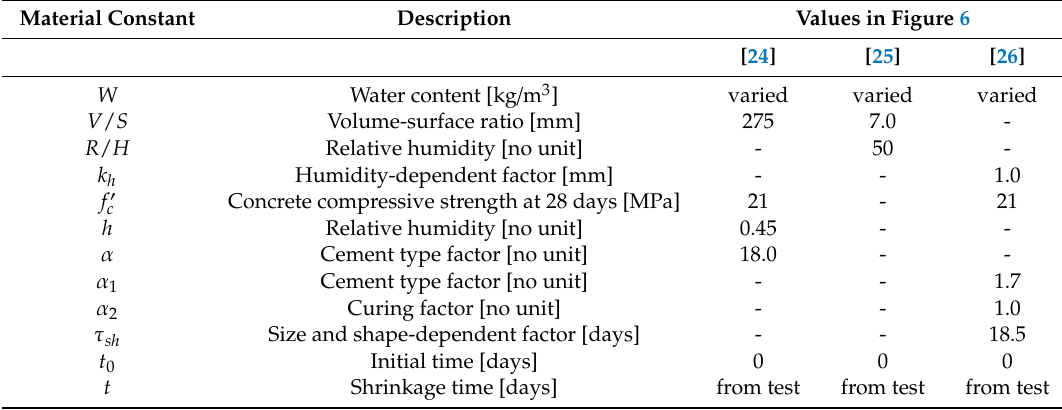
Table 6. Material constants for the model